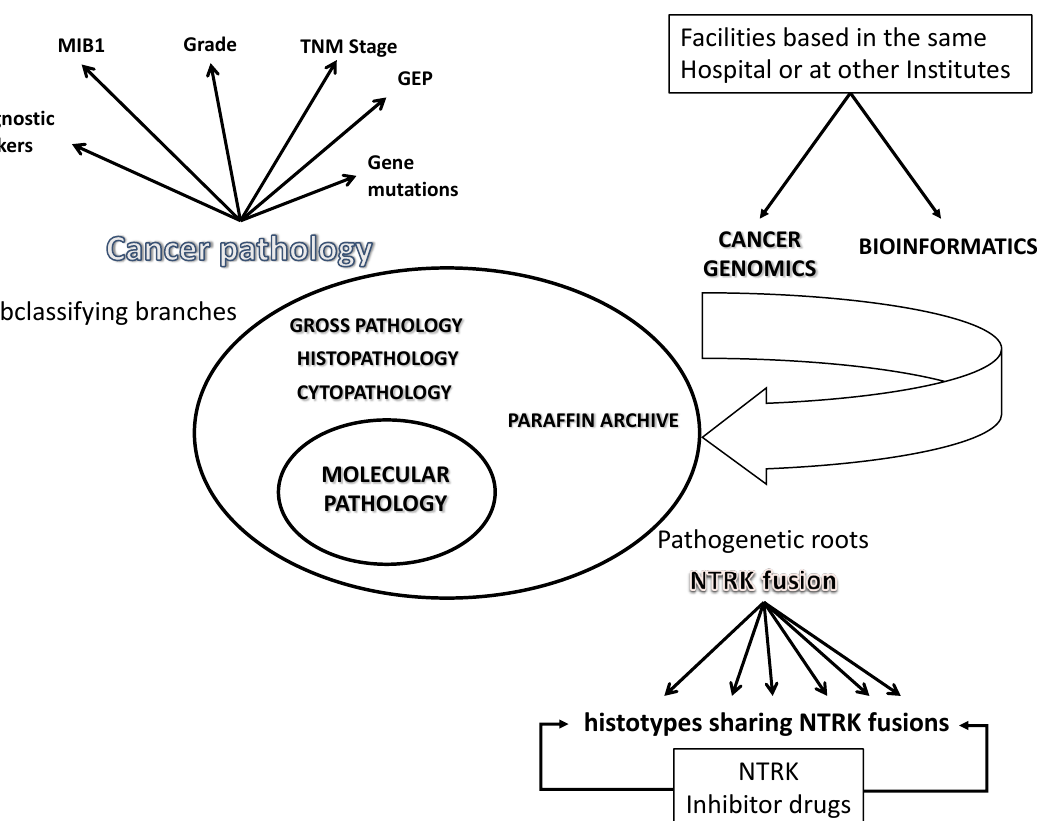
Figure 1. Standard classification and genomic profiling in a contemporary department of pathology. Facilities for cancer diagnosis and research carry out conventional histopathological analyses as well as biological and molecular – genetic analyses. The core structure also receives data from genomic and bioinformatics research facilities, either based in the same hospital or at other institutes. Standard pathology classification for cancer includes morphology, immunohistochemistry, and pTNM stage. Molecular profiling can refine this classification. Different tumor histotypes may share a genetic mutation, making them susceptible to treatment with the same drug. The figure illustrates how some tumors of various histotypes, grades and stages may be driven by a chromosomal rearrangement fusing a neurotrophic tropomyosin receptor kinase (NTRK) gene with another gene. Histotypes sharing NTRK fusions include thyroid carcinoma, melanoma, gastrointestinal stromal tumor, lung carcinoma, colon carcinoma, salivary gland tumor, central nervous system tumors, soft tissues sarcoma, infantile fibrosarcoma, and others (not shown). Abbreviations. GEP, gene expression profile; pTNM, pathologic TNM.